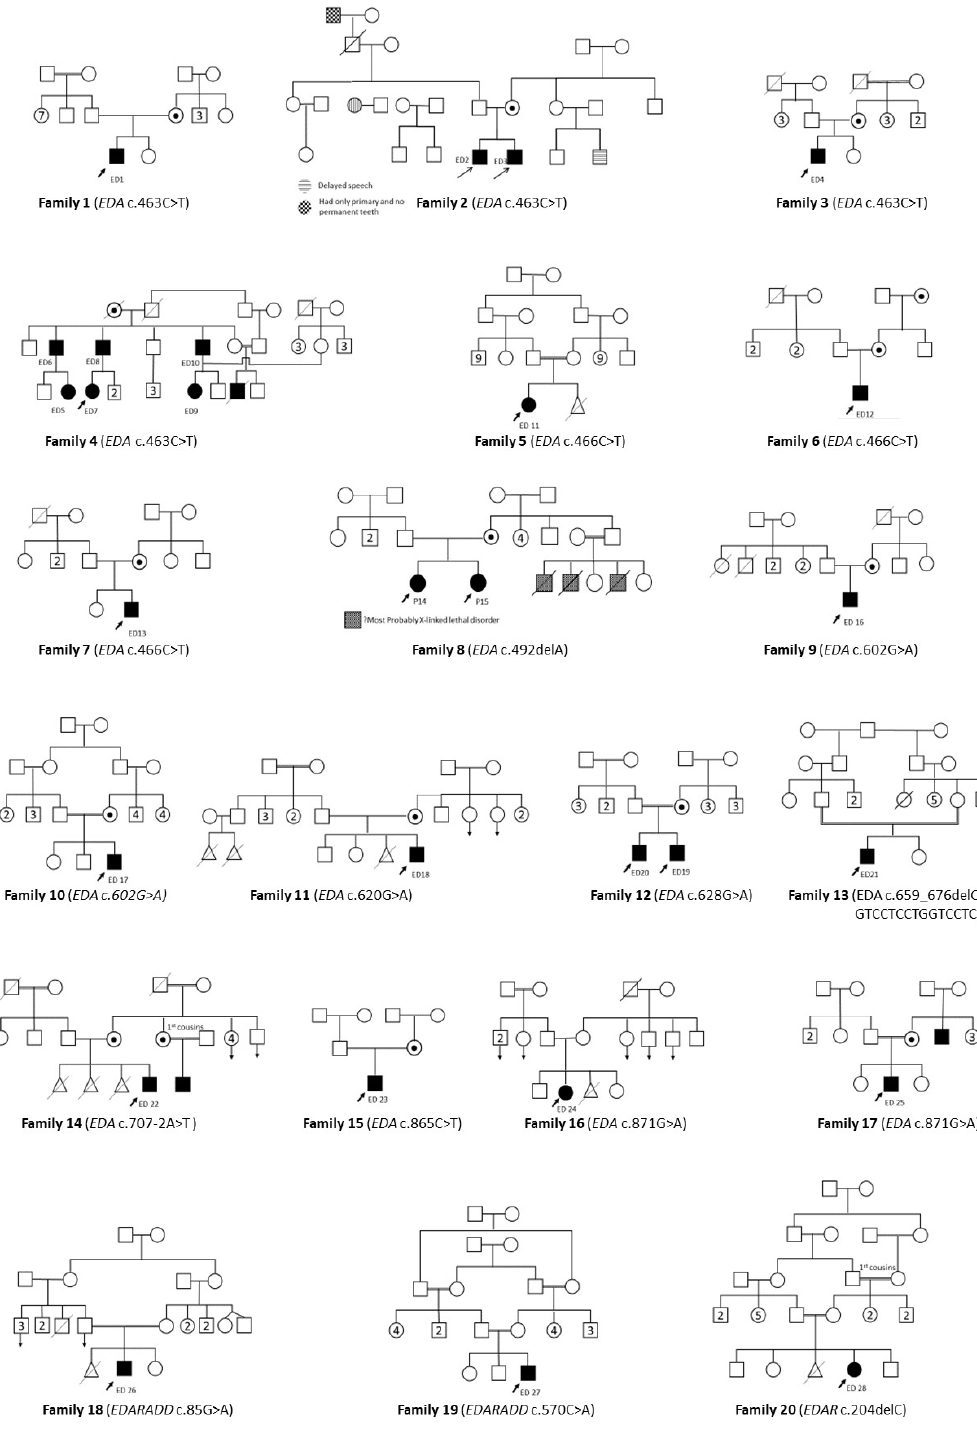
Figure 1. Pedigrees of molecularly identified ED patients. The figure shows 20 family pedigrees of 28 molecularly identified ED patients (ED1-ED28). Probands are denoted by black arrows, and the identified mutation is shown below each pedigree.